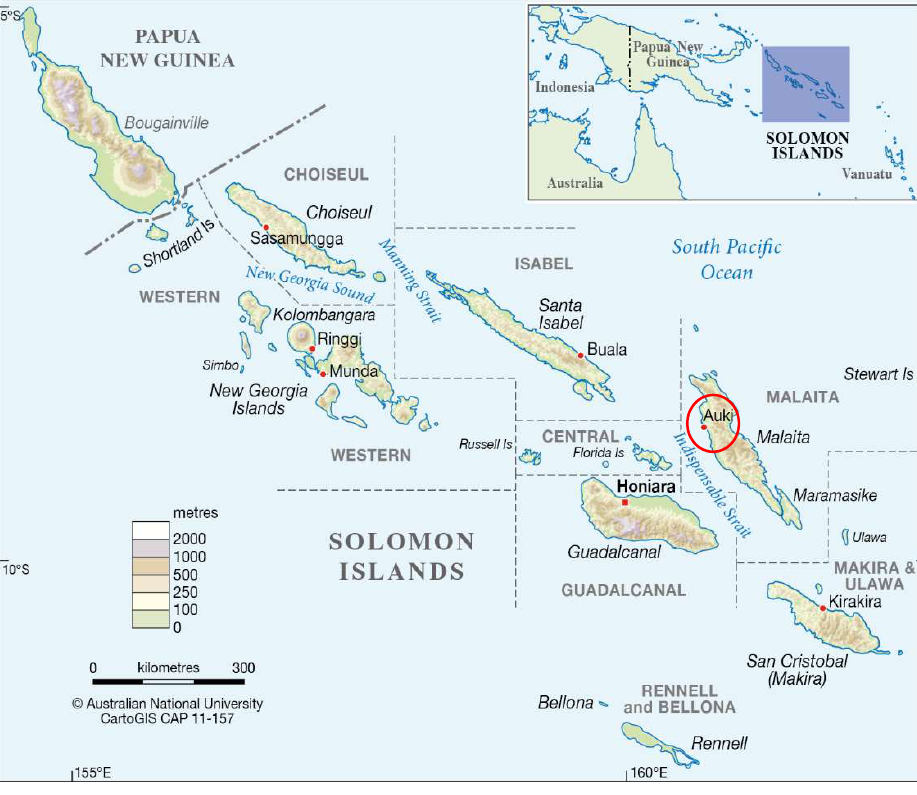
Figure 1. A colour relief map of the main Solomon Islands showing province borders, highlighting Auki’s location and including a location inset (Source: CartoGIS Services, College of Asia and the Pacific, The Australian National University) [26].